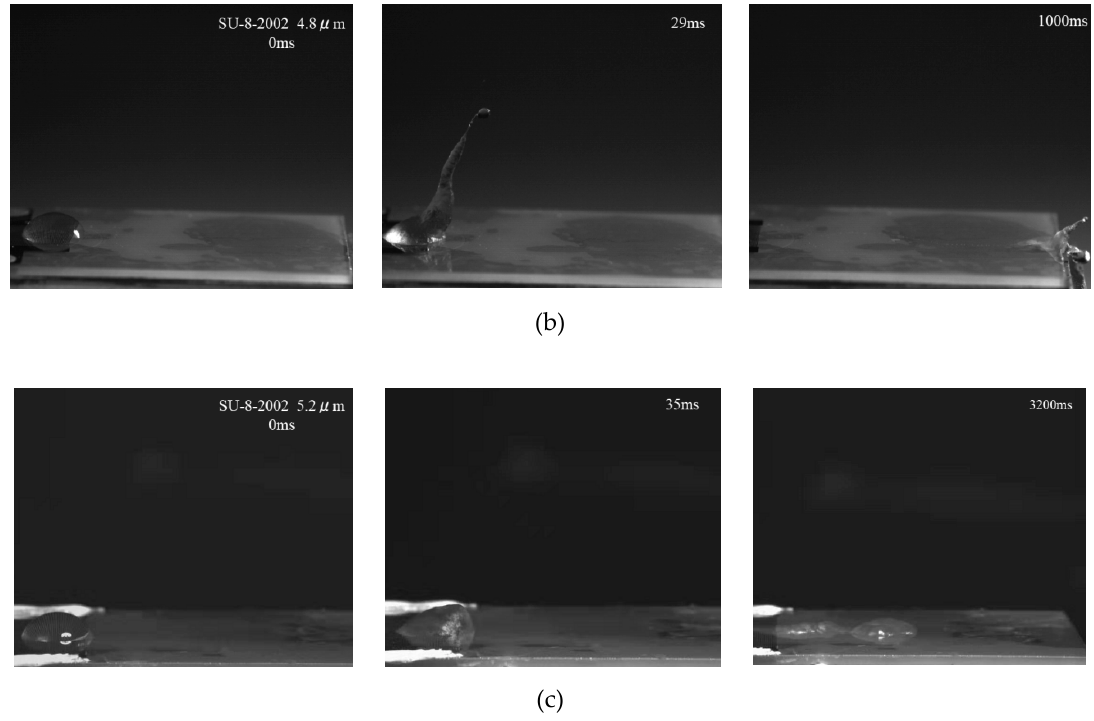
Figure 6. Waterproof performance test of SAW devices with different coating thicknesses. ( a ), ( b ), and ( c ) represent the thicknesses of 3.2 µ m, 4.8 µ m, and 5.2 µ m, respectively.